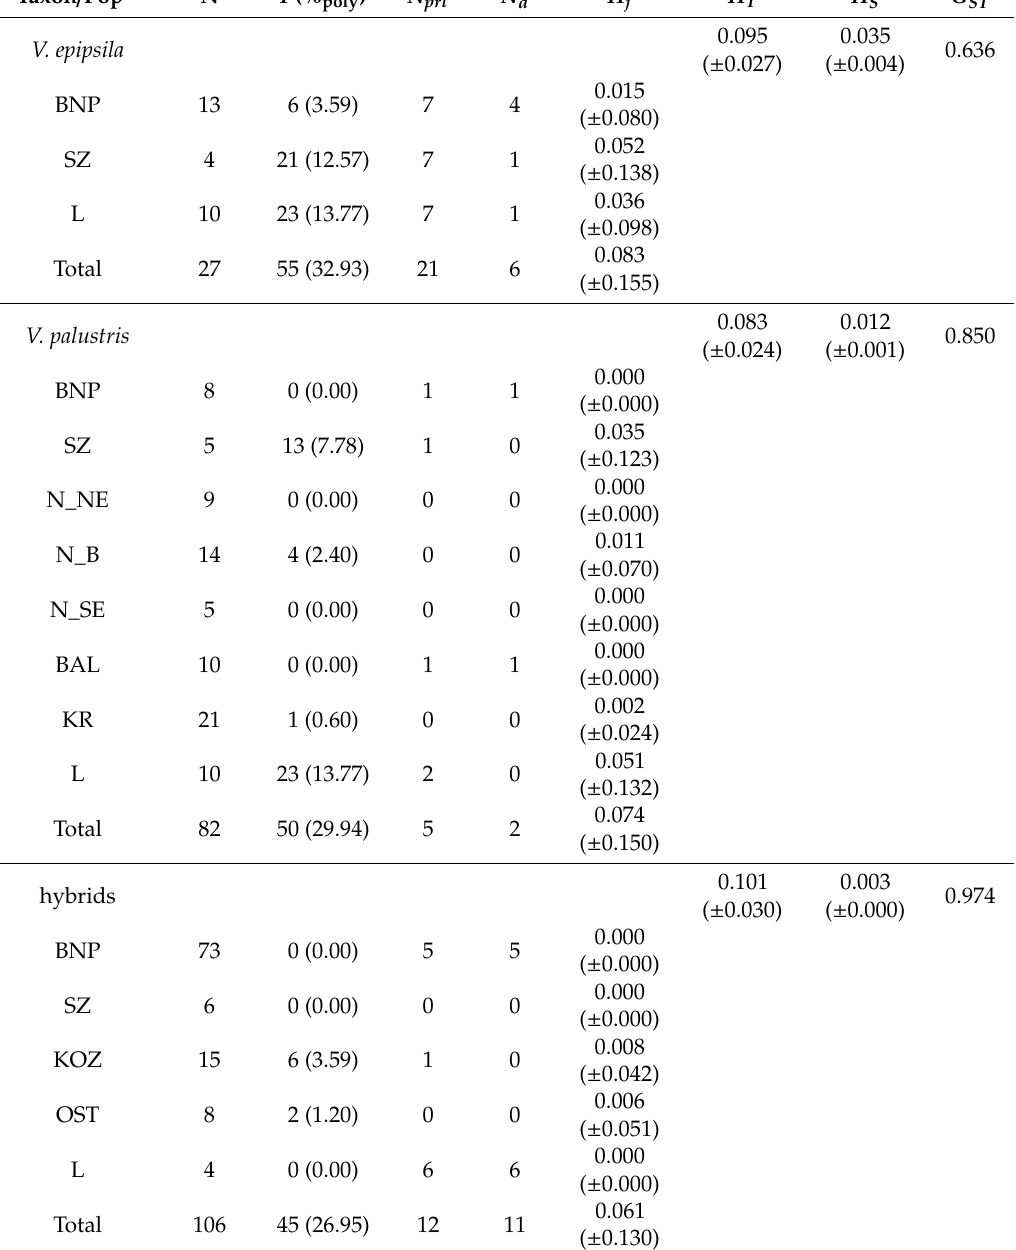
Table 2. Parameters of genetic diversity in V. epipsila , V. palustris and their putative interspecific hybrids. N—number of specimens used in genetic analyses; P —number of polymorphic markers; % poly —proportion of polymorphic markers; N prt —no. of private markers present in a given population but absent in other populations; N d —no. of discriminating markers present in all individuals of a given population, H j —Nei’s (1973) gene diversity; H T —total gene diversity; H S —mean gene diversity within populations; G ST —Nei’s (1973) gene diversity between